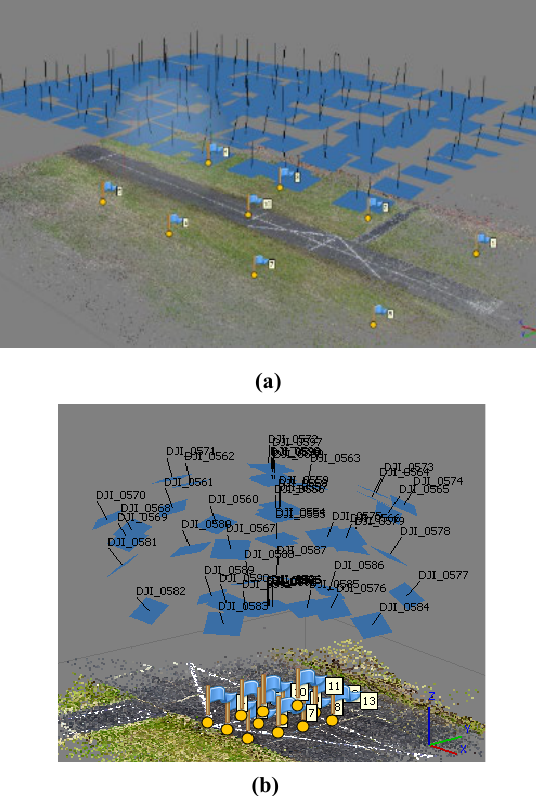
Figure 5. Photogrammetric blocks used to calibrate the camera: (a) cross-stripes block ( flight C ) with 111 (quasi-) nadiral images and 9 GCPs in which self-calibration was performed to estimate IO parameters; (b) calibration site with strongly convergent acquisition geometry used to compute initial values of IO